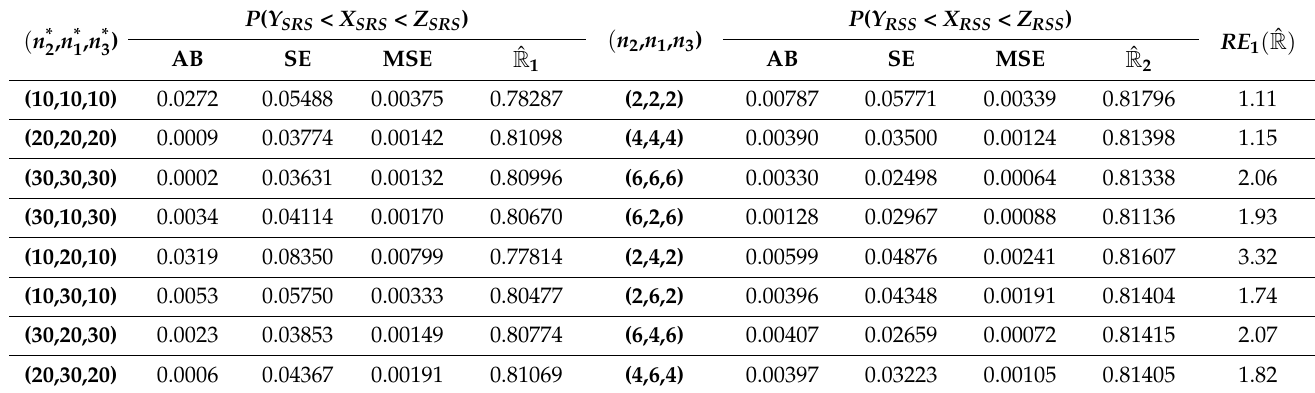
Table 3. Measurements of ˆ R 1 and ˆ R 2 for different sampling schemes at R = 0.81 and d = 5.